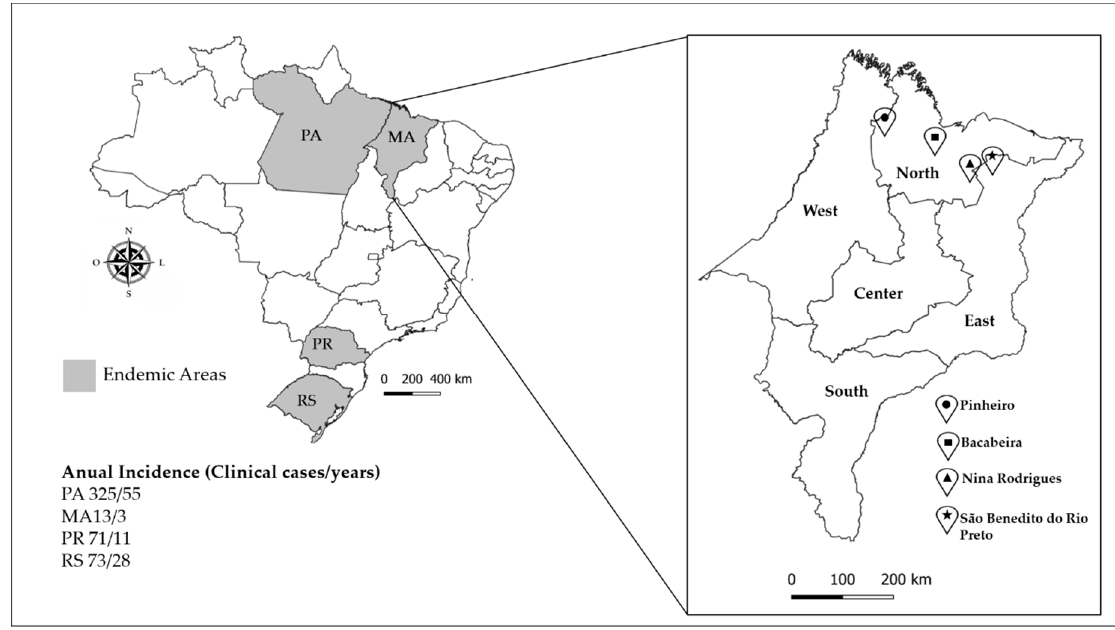
Figure 1. Study area of Maranhão state. The annual incidence of chromoblastomycosis in Maranhão state and endemic areas is shown in gray on the map [6]. The area of study was located in the North and East of Maranhão state. Bacabeira, latitude: 02° 58 ′ 15 ″ S; longitude: 44° 18 ′ 56 ″ W; altitude: 44 m; area: 650 km 2 . São Benedito do Rio Preto, latitude: 3° 19 ′ 59 ″ S; longitude: 43° 31 ′ 40 ″ W; altitude: 22 m; area: 931.48 km 2 . Pinheiro, latitude: 02° 31 ′ 17 ″ S; longitude: 45° 04 ′ 57 ″ W; altitude: 15 m; area: 1559 km 2 . Nina Rodrigues, latitude: 3° 27 ′ 53 ″ S; longitude: 43° 54 ′ 19 ″ W; altitude: 33 m; area: 572.5 km 2 .